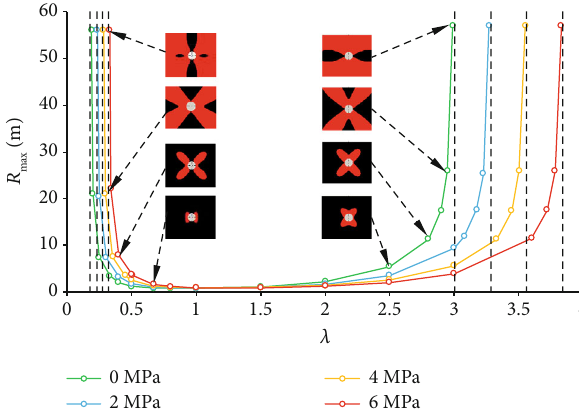
Figure 5: The relationship between radius of the plastic zone and stress under the di ff erent water